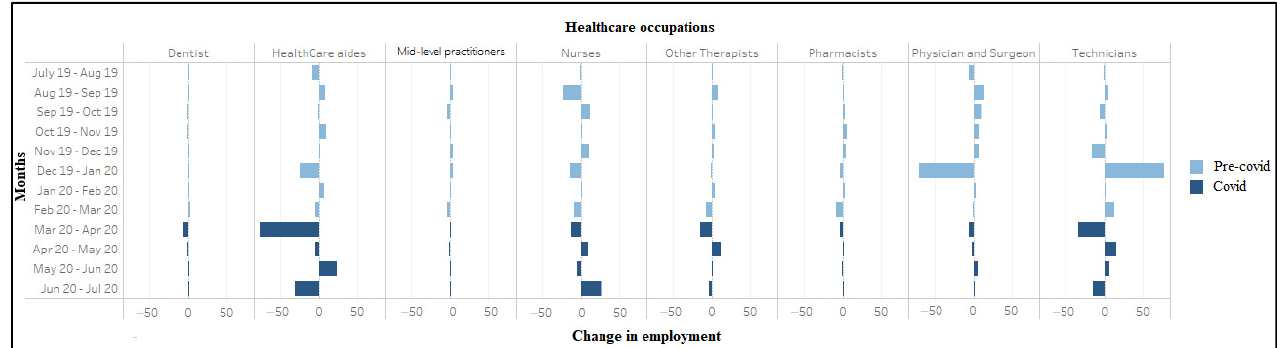
Figure 3. Change in employment (in ten thousand) among workers in healthcare industries (July 2019–2020).